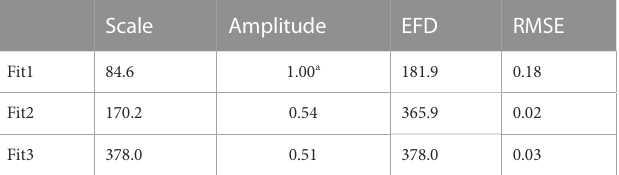
TABLE 3 The scale parameter ( α − 1 ), amplitude A ), effective e-folding distance (EFD), and root-mean-square error (RSME) for three fi ts to horizontal daily snow depth increment correlations. All units are km except for the dimensionless